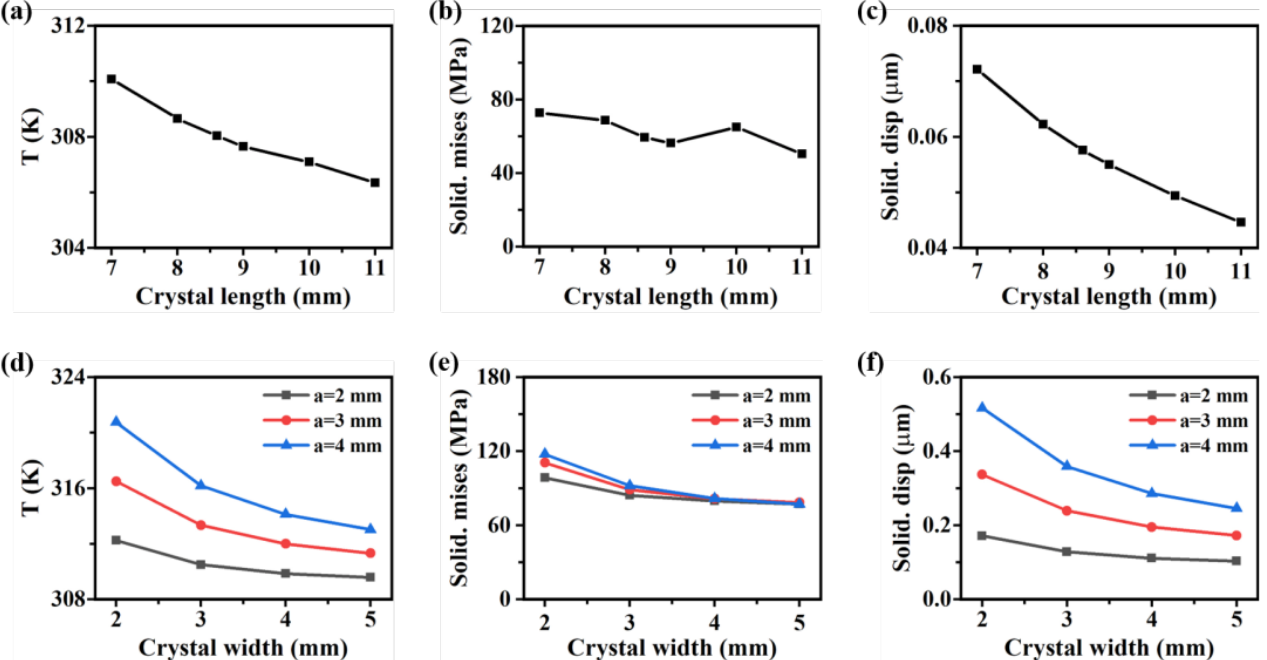
Figure 8. Distribution of ( a ) maximum temperature, ( b ) maximum thermal stress, and ( c ) maximum thermal deformation inside diamond crystals of different lengths. Distribution of ( d ) maximum temperature, ( e ) maximum thermal stress, and ( f ) maximum thermal deformation inside the diamond crystal for different crystal widths and thicknesses.